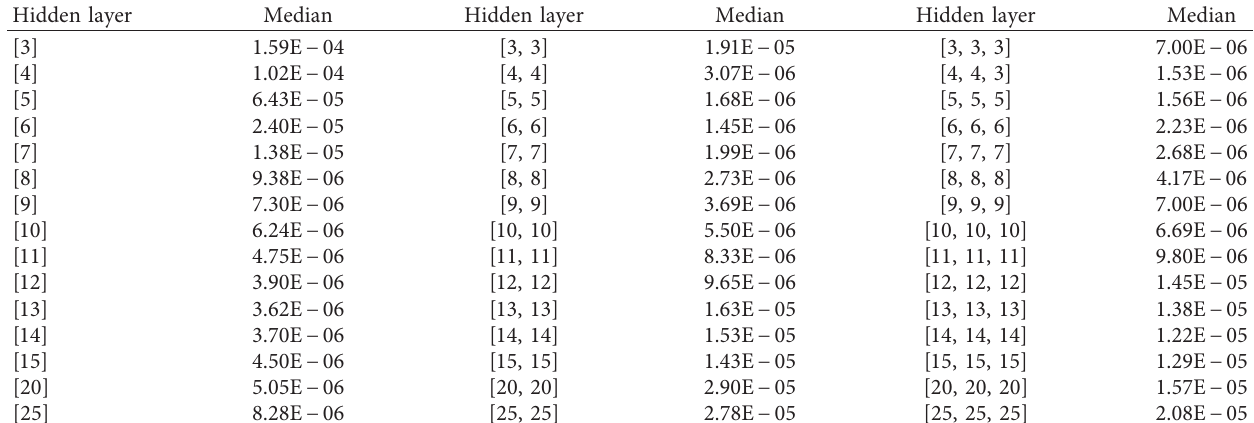
Table 1: Comparison results of the median of MSE of different hidden layer